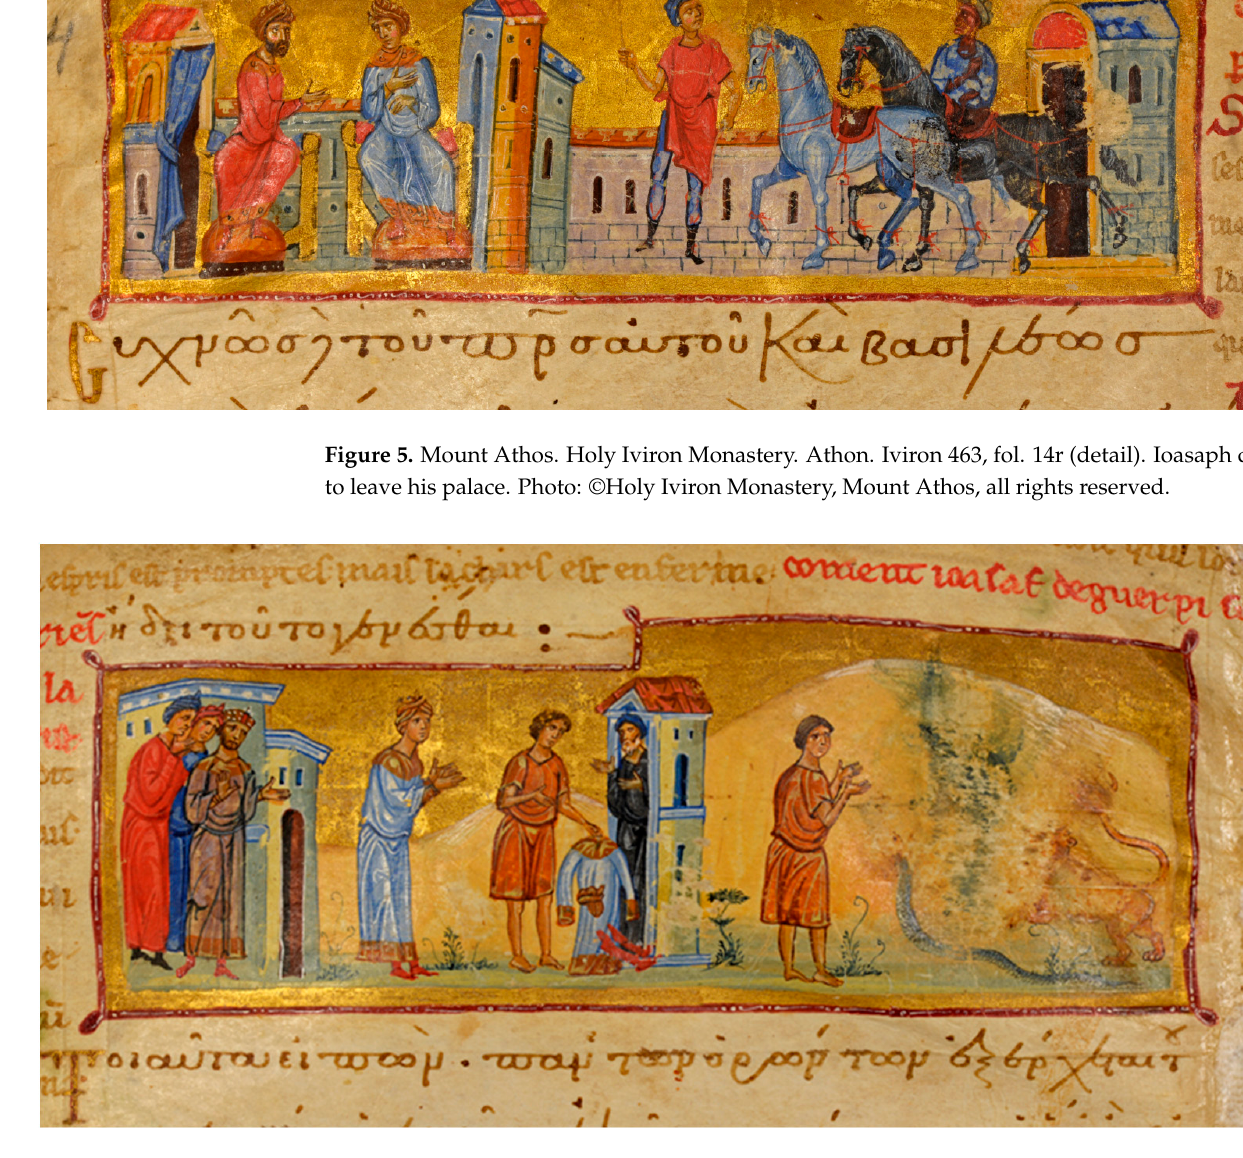
Figure 6. Mount Athos. Holy Iviron Monastery. Athon. Iviron 463, fol. 123v (detail). Ioasaph aban- dons his clothes and retreats to the desert. Photo: ©Holy Iviron Monastery, Mount Athos, all rights reserved.